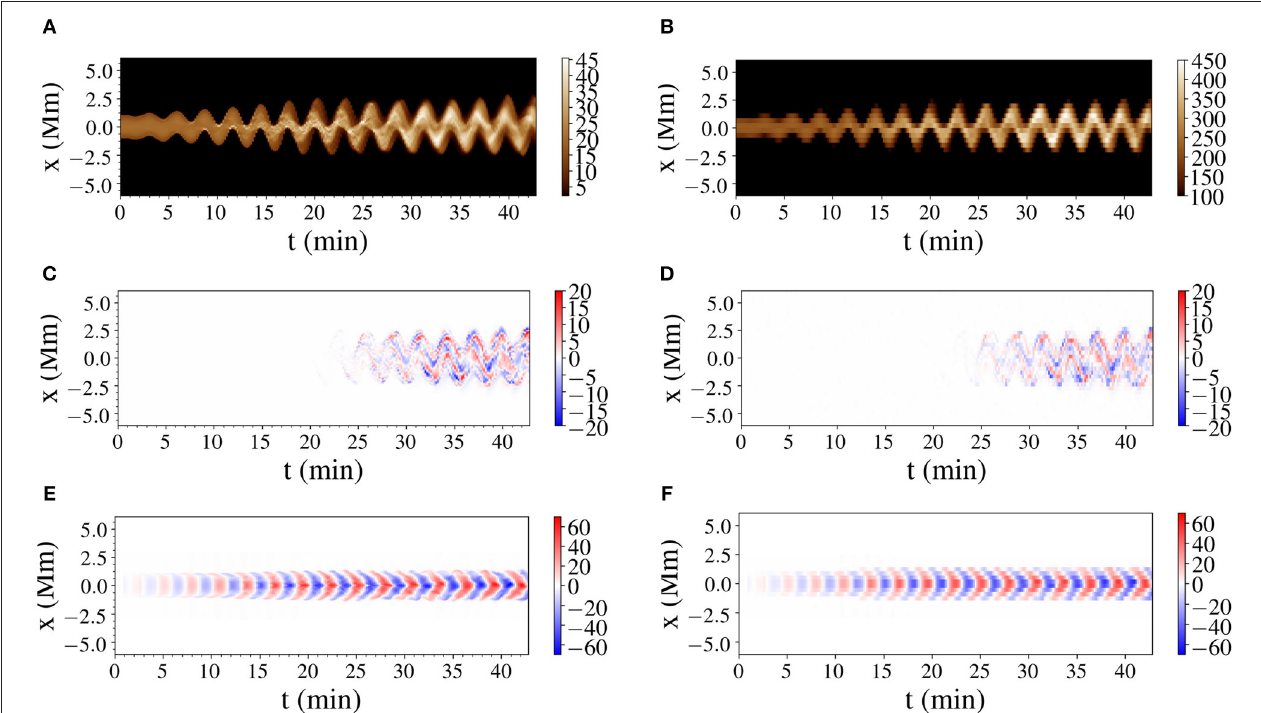
FIGURE 3 | Forward modeling results for the D2 model in the Fe XII 193 Å line at the apex. The left panels show the images for numerical resolution and the right panels the images for the targeted instruments. (A,B) Show the emission intensity (in ergs cm − 2 s − 1 sr − 1 ) for numerical and for AIA resolution respectively. (C,D) Show the Doppler velocity (in km s − 1 ) at 0 ◦ , for numerical and for EIS resolution respectively. (E,F) Doppler velocity (in km s − 1 ) at 90 ◦ , for numerical and for EIS resolution, respectively.